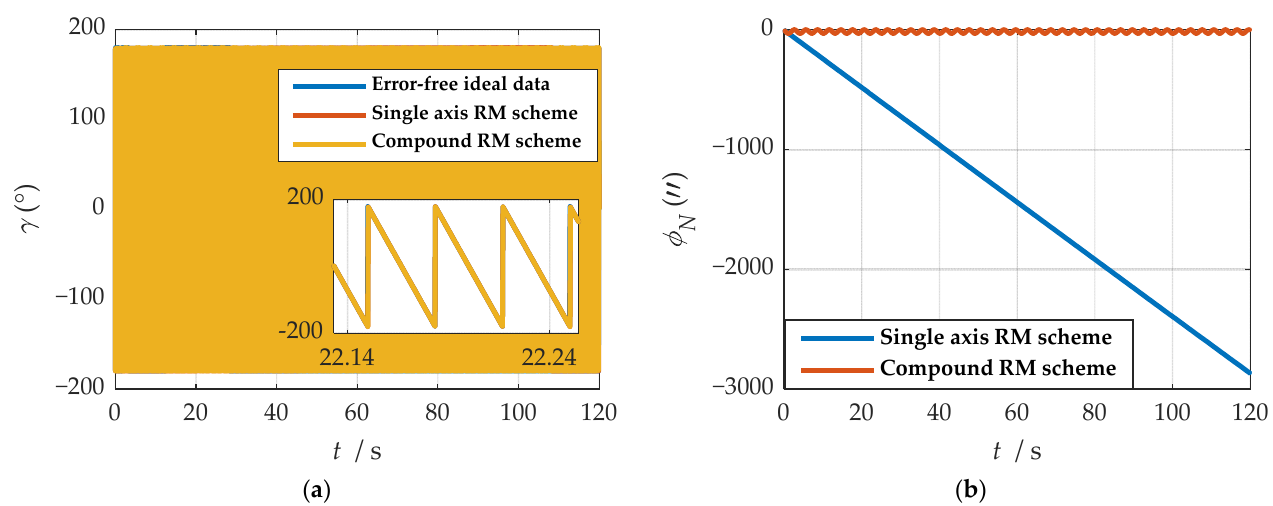
Figure 19. The navigation results comparison of the rotation scheme: ( a ) comparison of calculation results of roll angle; ( b ) comparison of calculation results of north misalignment angle.